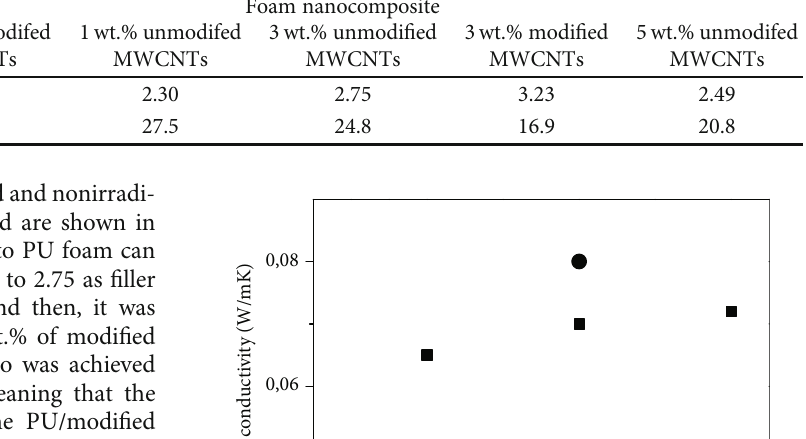
Foam nanocomposite